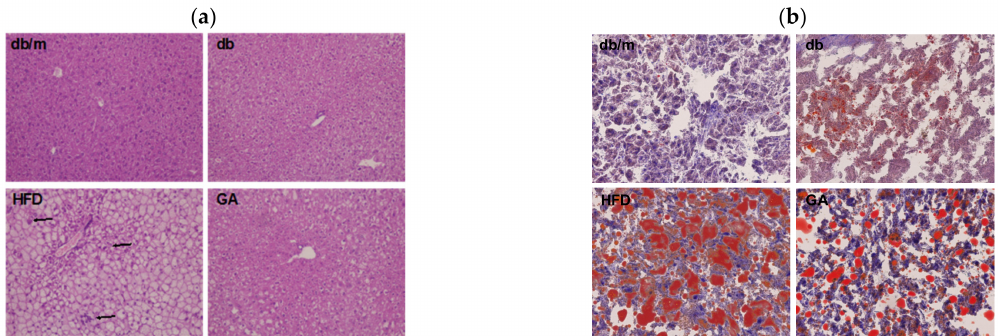
Figure 1. HFD induced hepatic steatosis, and GA improved lipid accumulation in diabetic mice. 6-week-old male db/db mice fed with HFD and 100 mg/kg GA for 12 weeks. ( a ) H&E (100 × ) and ( b ) Oil Red O staining (200 × ) of liver frozen sections. The accumulation of polymorphonuclear leukocytes is indicated with an arrow. db/m, age-matched heterozygous mice fed with standard diet group; db, db/db mice fed with standard diet group; HFD, db/db mice fed with HFD group; GA, db/db mice fed with HFD and GA